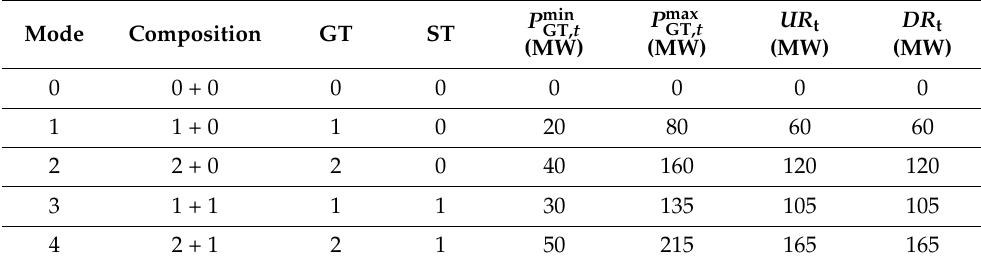
Table 4. Composition data for CCGT.